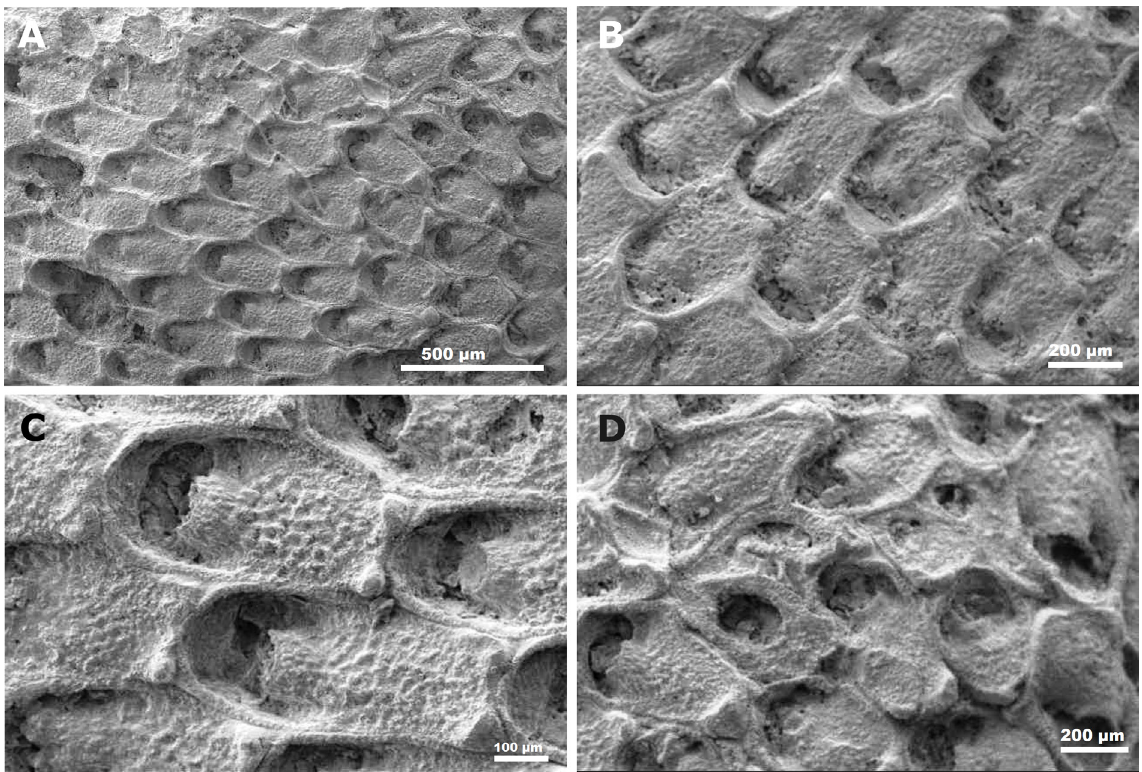
Fig. 11. Labioporella hariparensis Guha & Gopikrishna, 2007 (GIS/B 0533). A . General view of the colony showing autozooids. B . Enlargement of an autozooid showing cryptocyst and polypide tube. C . Close-up of the colony showing autozooid with proximal tubercles. D . Enlargement of the colony showing ancestrula and interzooecial